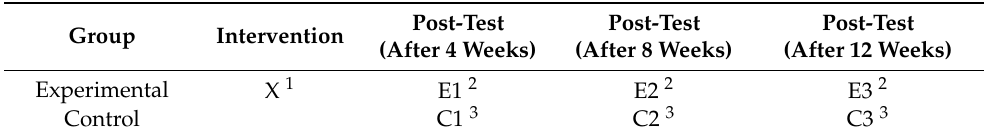
Table 1. The research design of the study. Post-Test Post-Test Post-Test Group Intervention (After 4 Weeks) (After 8 Weeks) (After 12 Weeks) Experimental X 1 E1 2 E2 2 E3 2 Control C1 3 C2 3 C3